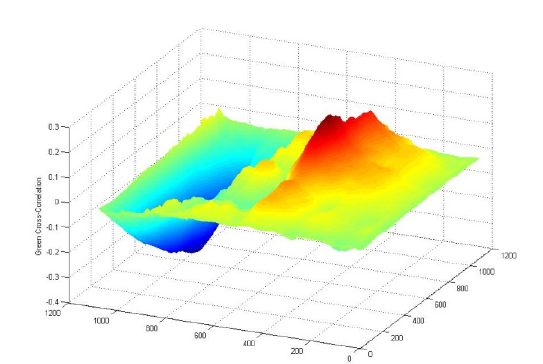
Figure 4. Cross Correlation between the RGB and X-SAR coregistered